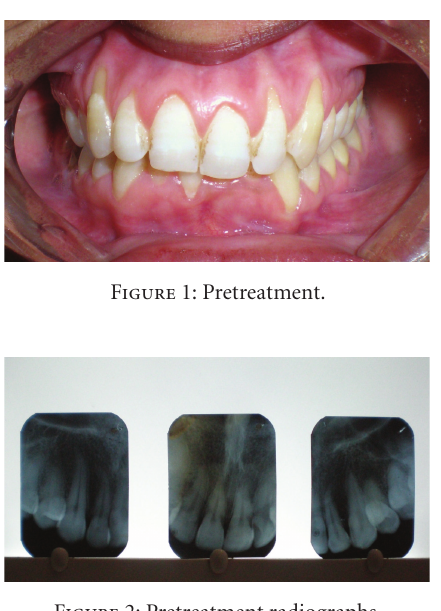
Figure 2: Pretreatment radiographs.